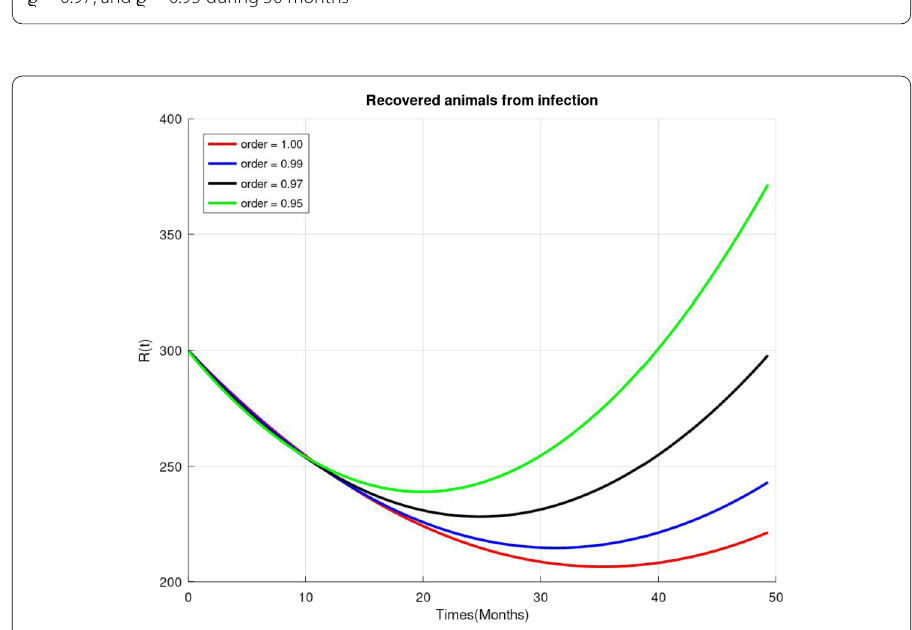
Figure 4 An illustration of the total number of recovered animals R ( t ) for different orders (cid:2) = 1, (cid:2) = 0.99, (cid:2) = 0.97, and (cid:2) = 0.95 during 50 months